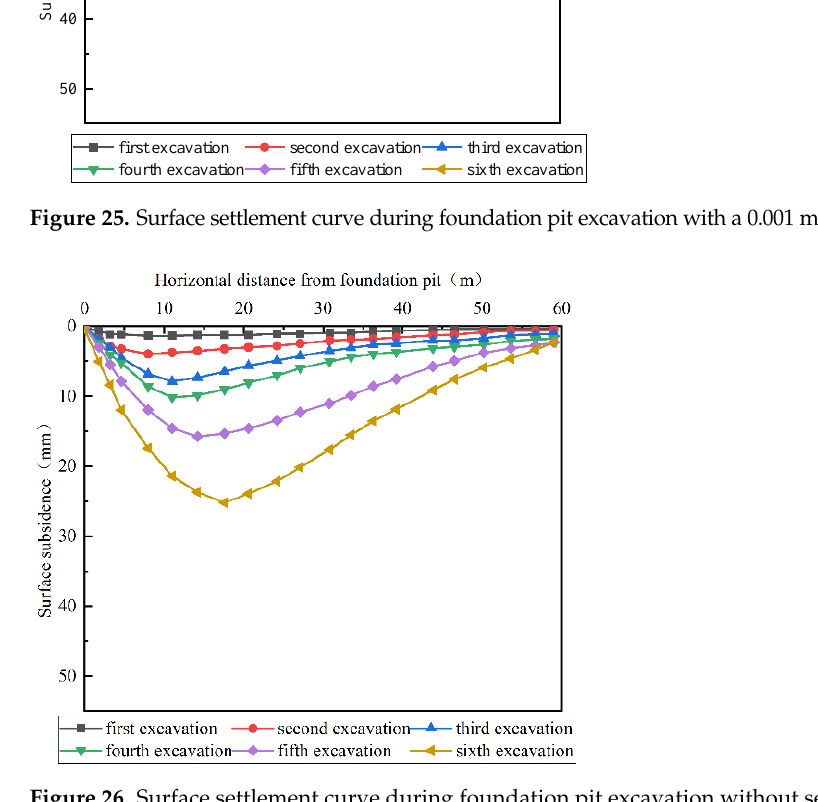
Figure 26. Surface settlement curve during foundation pit excavation without seepage point.